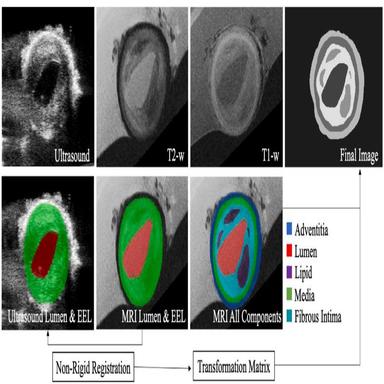
Ultrasound and co-registered T1 and T2-weighted MR images of a sample with lipid pools. The lumen (red) and external elastic lamina (EEL) (green) were segmented both on the ultrasound and MR images to obtain the transformation matrix by the non-rigid registration. Then, the transformation matrix was applied on the lumen (red), fibrous intima (turquoise), lipid (purple), media (green) and the adventitia (blue) segmented T2-weighted MR image to obtain the final registered image.